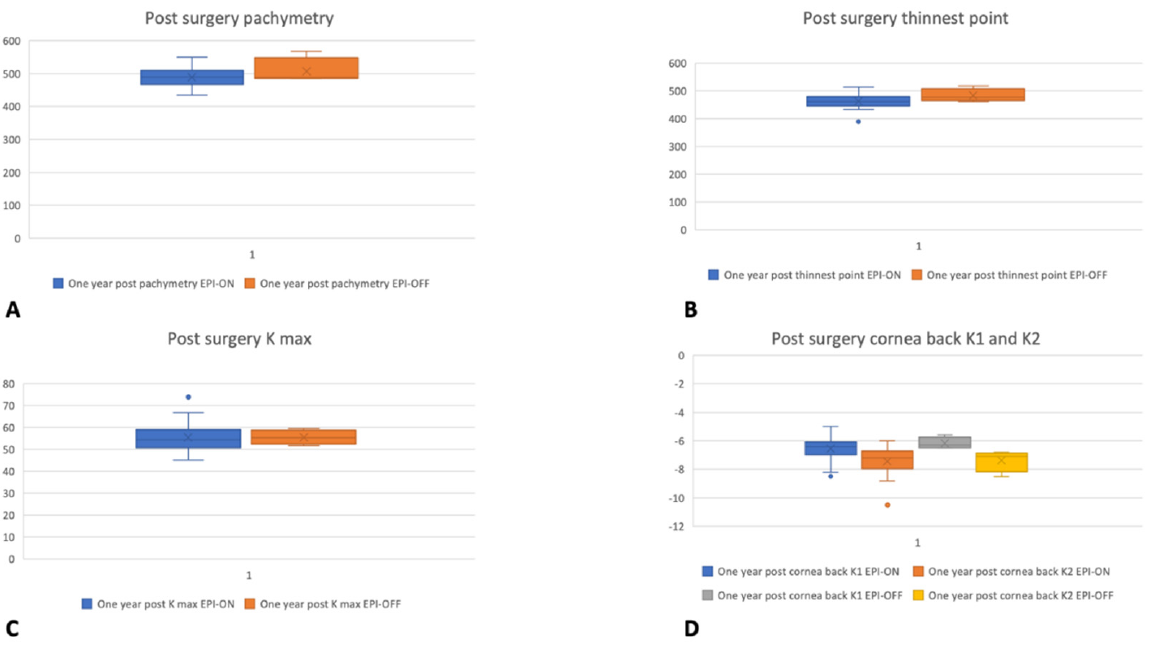
Figure 1 . Kmax ( A ), Pachymetry ( B ), thinnest point ( C ), and cornea back ( D ) topographic outcomes before surgery and after one year of follow-up in the epi-on and epi-off groups. The ANOVA Univariate analysis highlighted no statistically significant differences in the Average Pachymetry and the Topographically Thinnest Point between groups during the follow-up period; this is best displayed in Figure 1. Moreover, statistically significant differences between Kmax values before surgery and after 1 month ( p < 0.008), 3 months ( p > 0.001), and 6 months of the follow-up period ( p > 0.002) were identified. On the one hand, during the follow-up period, Kmax values were on average higher than time zero. On the opposite side, the Kmax values came back to the before surgery values at the last follow-up after 24